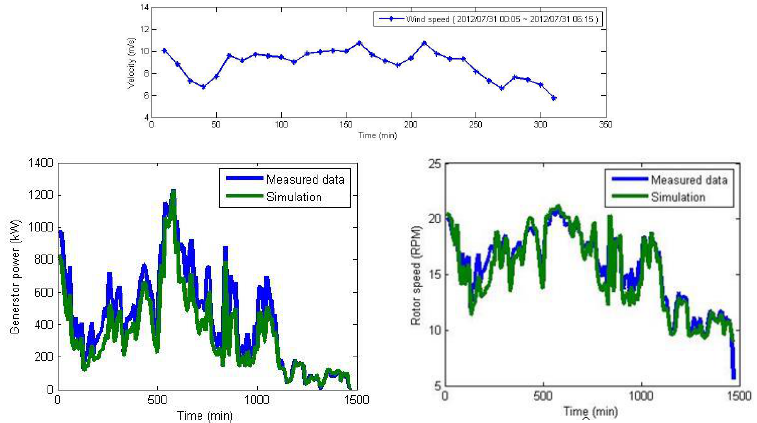
Figure 17. Overall comparison of 2 MW wind turbine: 2012/07/31 00:05–06:15.